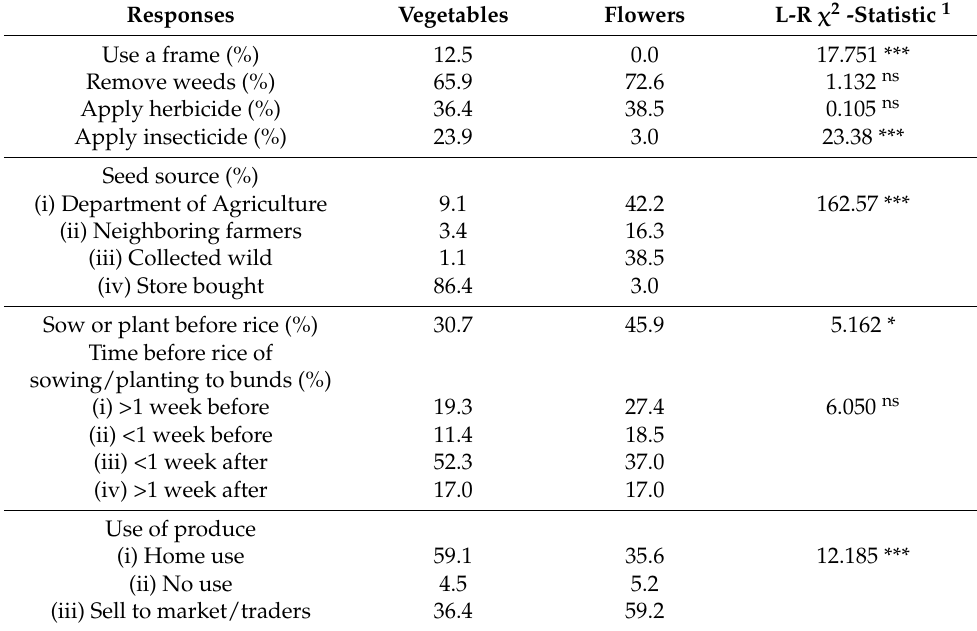
Table 2. Management of flowers and vegetables grown on rice bunds as part of ecological engi- neering for pest management. Note that these farmers were all currently participating in ecological engineering (current-EE). For comparisons between conventional, current-EE and former-EE see Table S2, and for a list of vegetable and flower species planted on bunds see Table S3. Responses